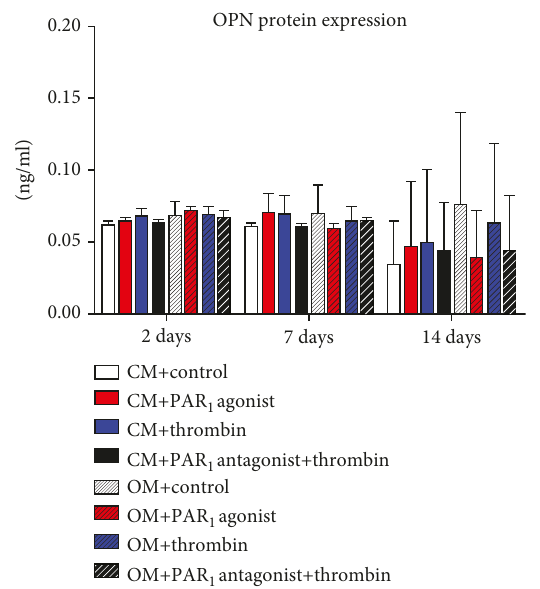
Figure 9: E ff ects of PAR activation on OPN protein expression at 1 2, 7, and 14 days. Values are presented as mean and SEM; n = 3